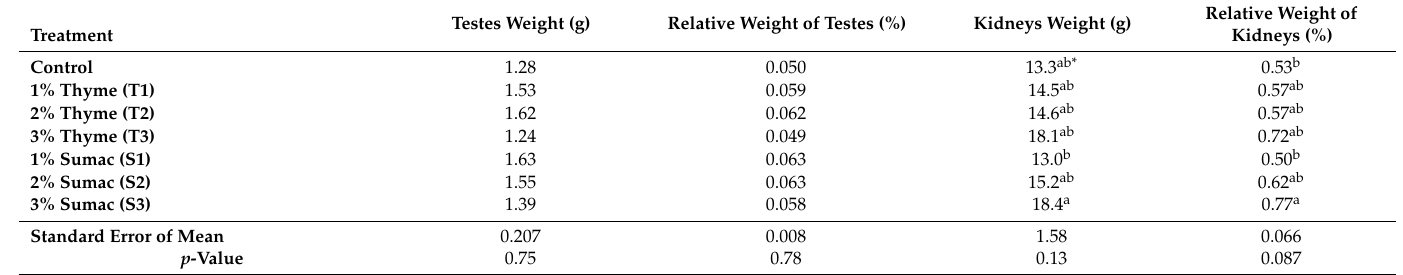
Table 5. Testes and kidney weights at 42 days of age in Ross 308 broilers fed diets containing 0, 1, 2, and 3% thyme (T3) and sumac from days